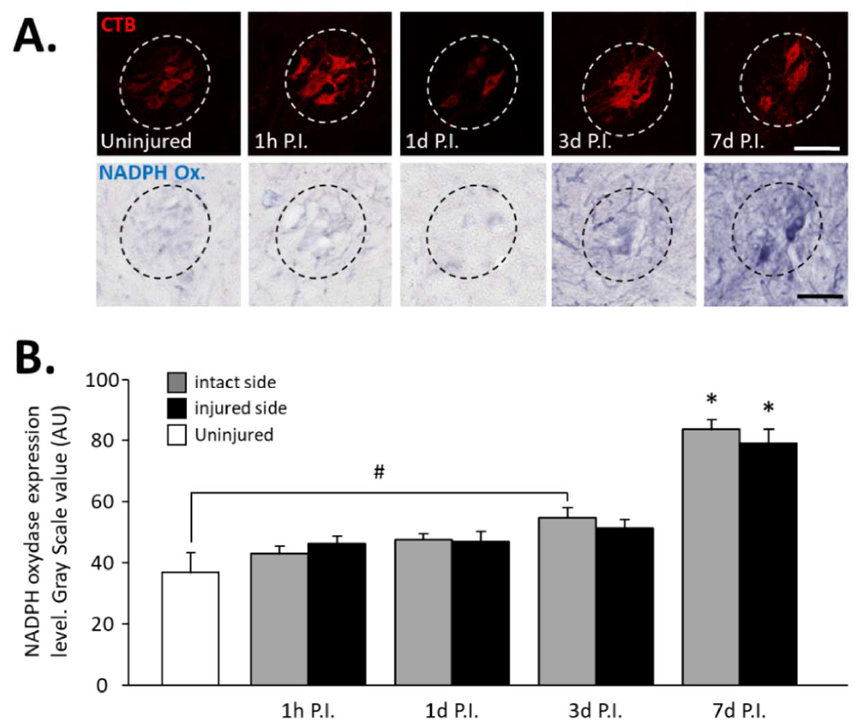
Figure 2. NADPH oxidase expression in phrenic motoneurons following C2 hemi-section. ( A ) Rep- resentative images showing expression of NADPH oxidase in phrenic motoneurons labeled with CTB in uninjured animals and in denervated phrenic motoneurons in C2 hemisected rats, 1 hour (h), 1 day (d), 3 d, and 7 d post-injury (P.I.). ( B ) Quantification of NADPH oxidase in phrenic motoneurons for uninjured animals, and intact and injured sides of C2 hemisected animals 1 h, 1 d, 3 d, and 7 d following injury. # 3 d P.I. intact side, compared with uninjured group, p < 0.05. * 7 d P.I. compared to uninjured group and 1 h P.I. corresponding side, p <